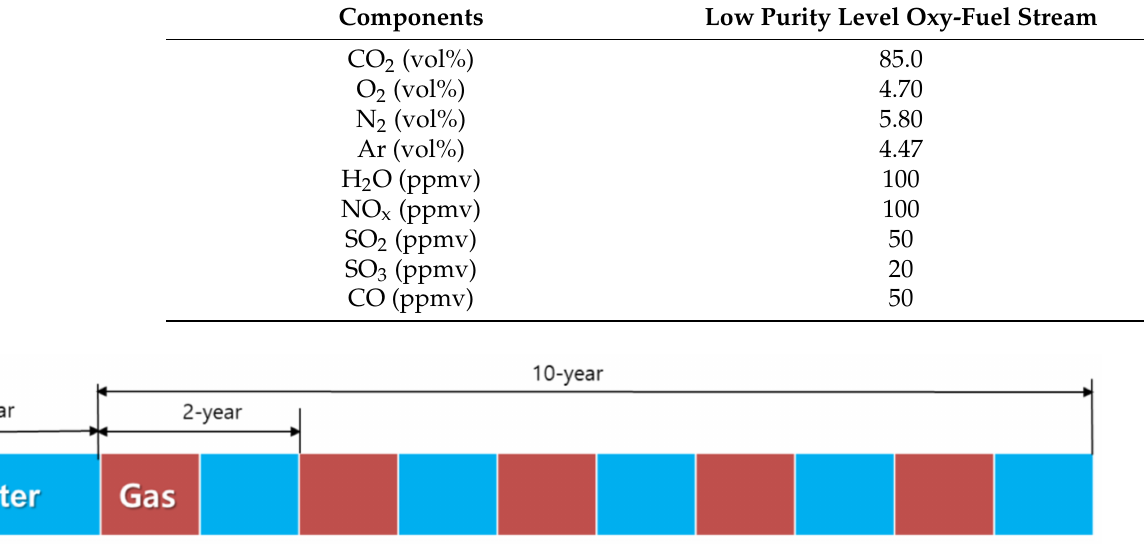
Table 5. Composition of CO 2 impurities from the low purity Oxy-fuel stream.